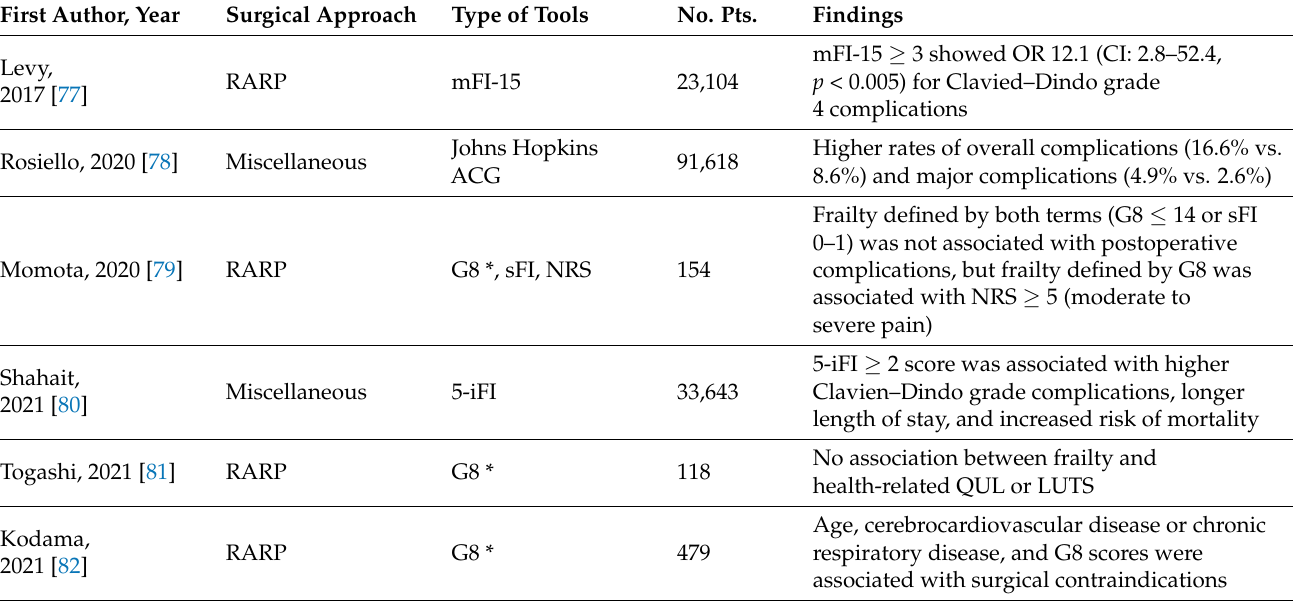
Table 2. Relationships between frailty and postoperative outcomes in radical